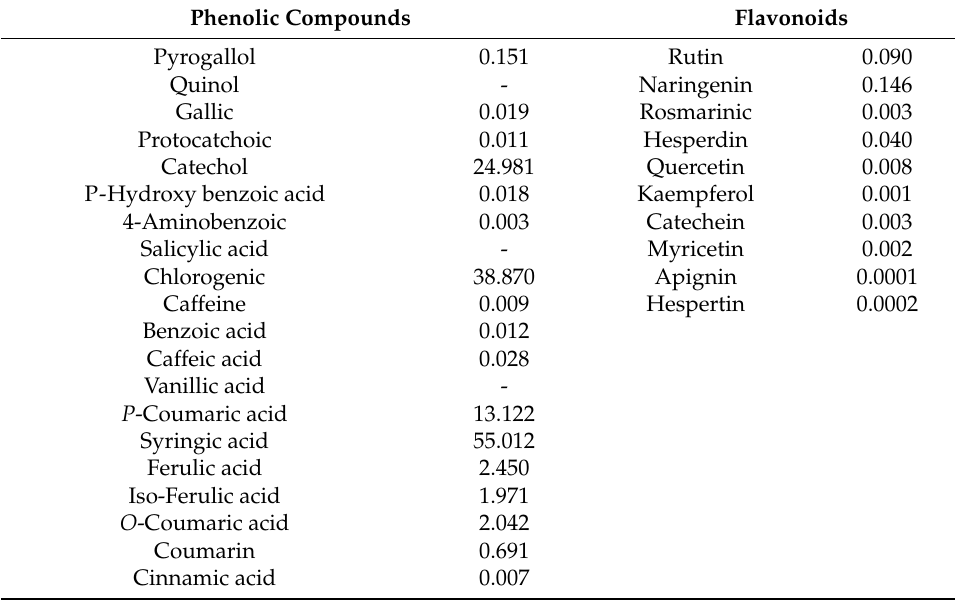
Table 2. The quantity of the identified phenolic compounds and flavonoids (mg/g) in DBRE extract as estimated by